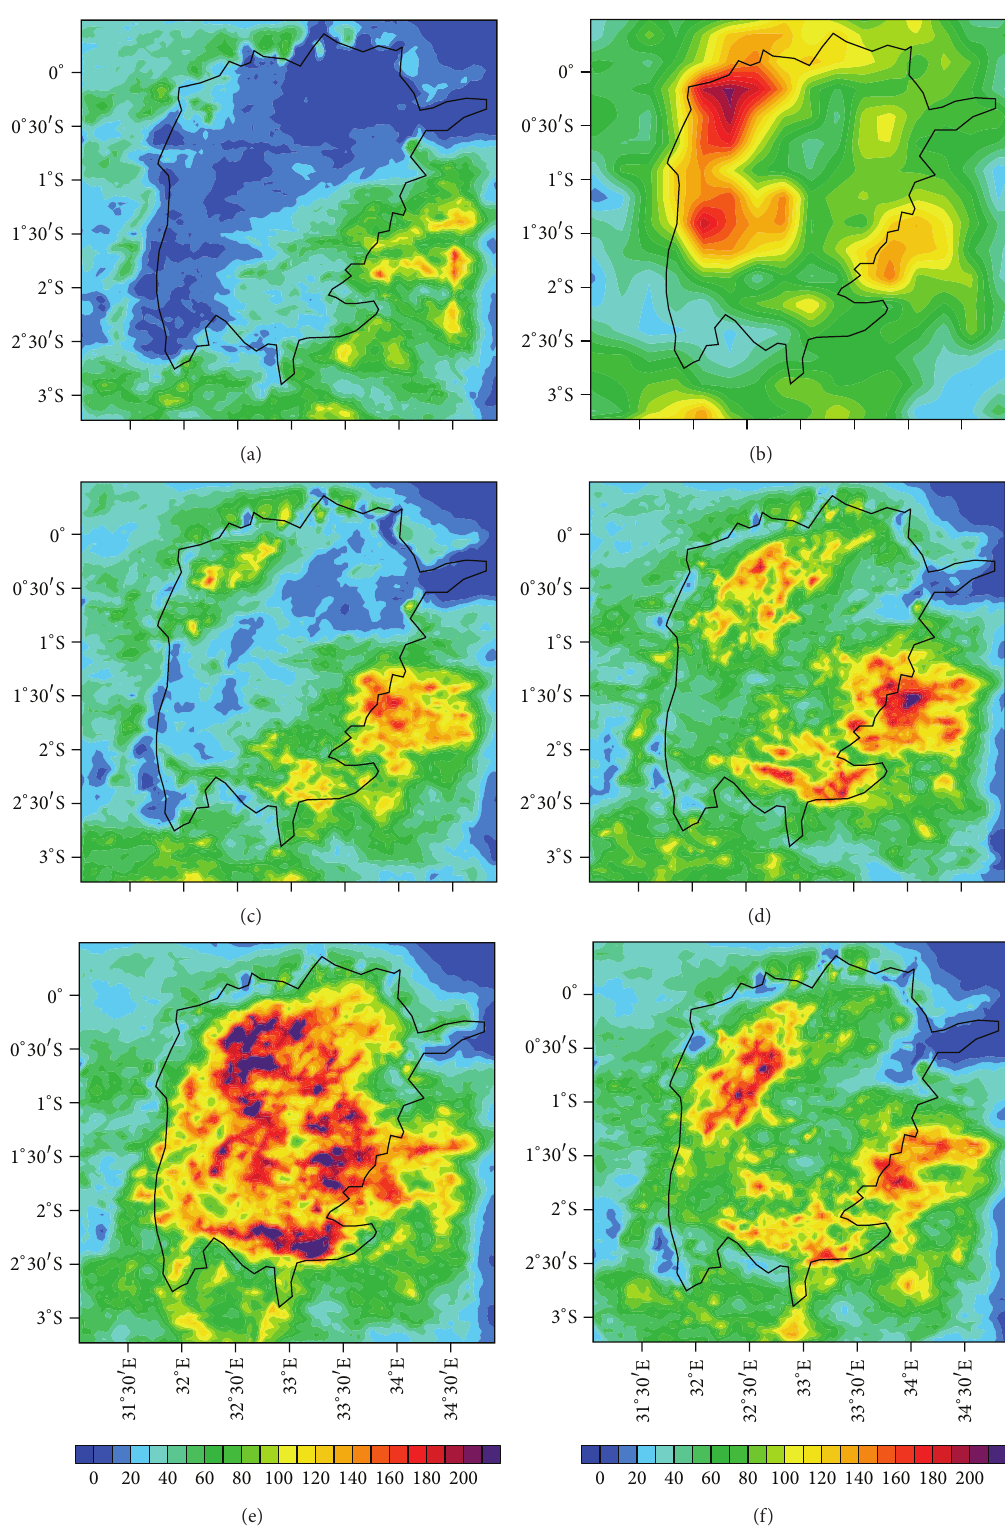
Figure 6: Total rainfall pattern during the five-day period from (a) the control run, (b) the TRMM data, (c, d, e) the experiments with area-averaged LST being 22.5 ∘ C, 24 ∘ C, and 25.5 ∘ C, and (f) the experiments with LST pattern from Anyah